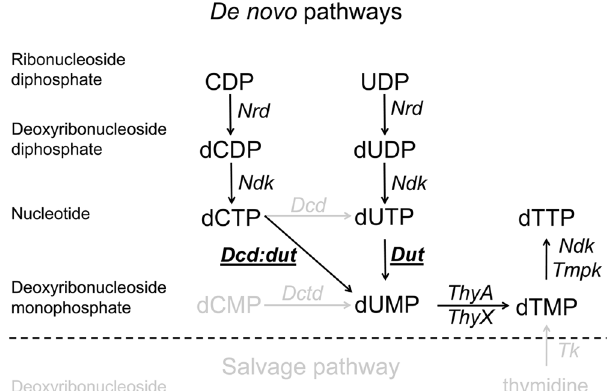
Figure 1. dTTP biosynthesis pathways and enzymes. Processes present in Mycobacteria are shown in black. Most organisms encode for additional de novo and salvage pathways that are shown in grey. Abbreviations: